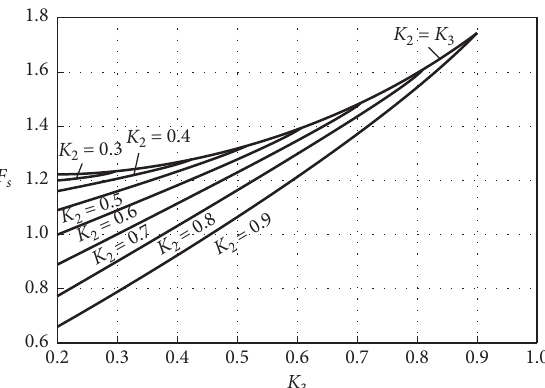
Figure 7: Factor of safety charts for water sudden drawdown